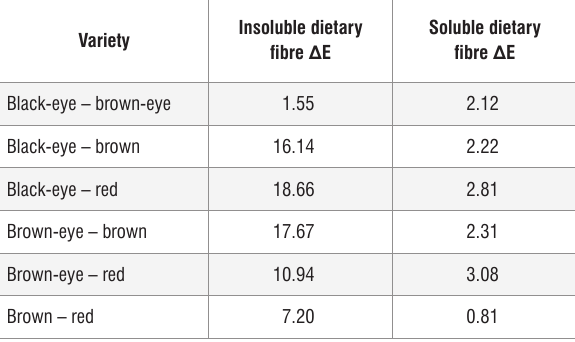
Colour differences (∆E) between Bambara groundnut die- tary fibres